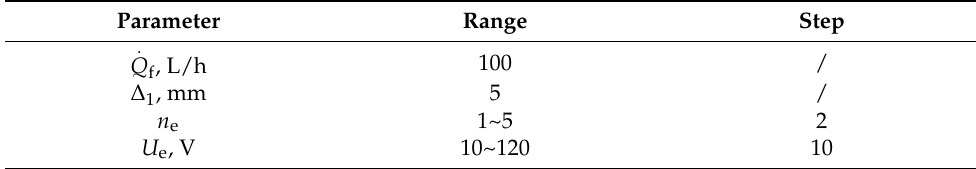
Table 3. Experimental conditions for Factor 1.